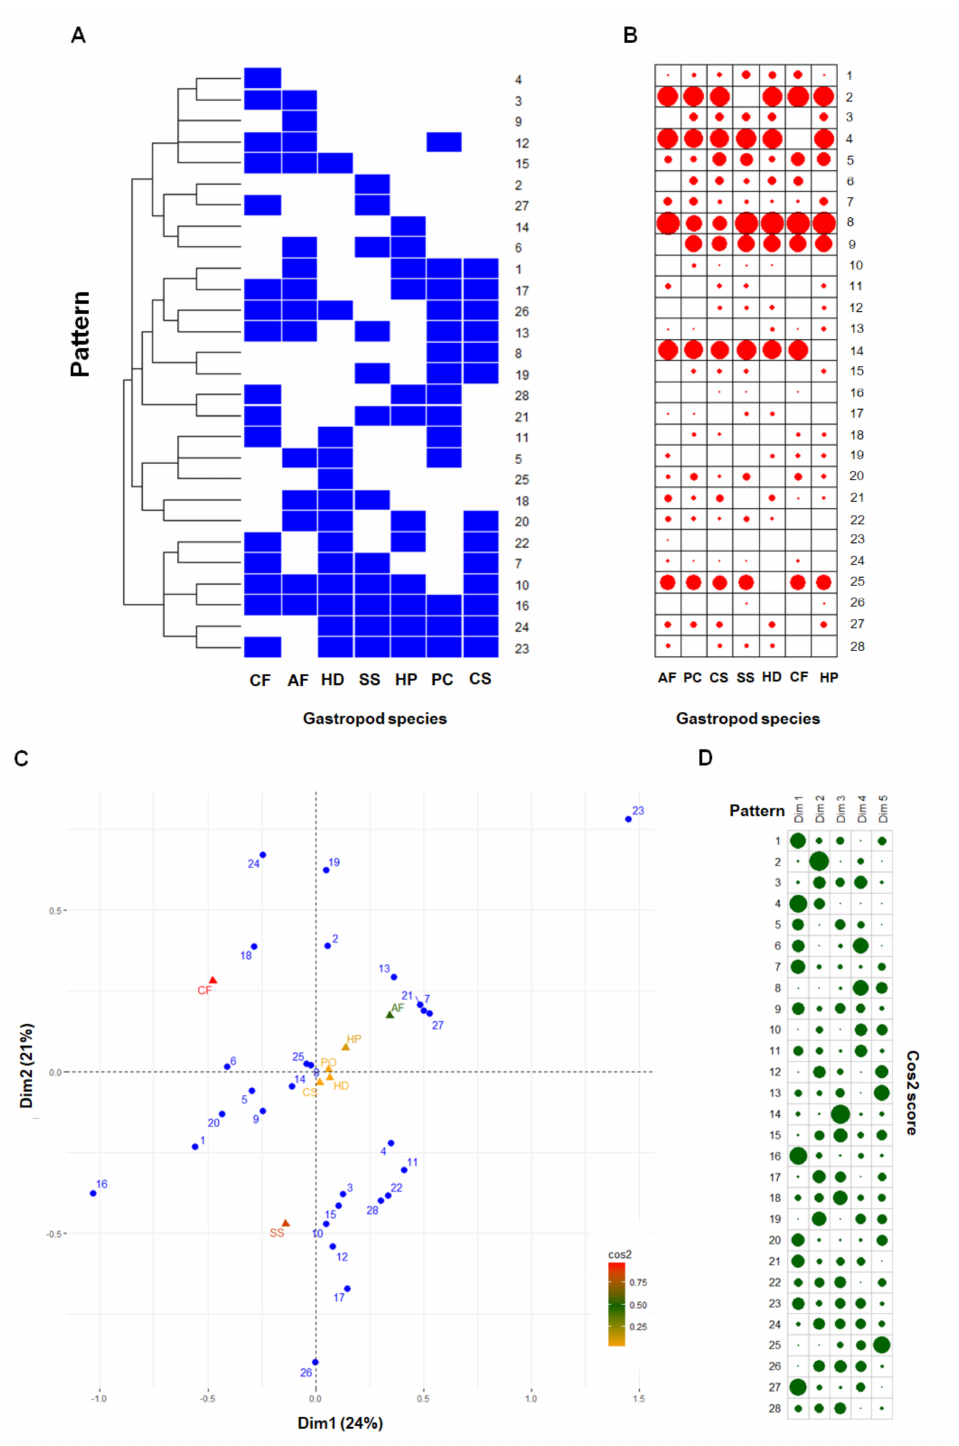
Figure 4. Correspondence analysis of 28 patterns of variable peptides in the mucus of seven gastropod species. Blue squares in the heatmap ( A ) indicate the presence of the peptide, and white squares indicate the absence of a peptide. The sizes of the red circles in the balloon plot ( B ) indicate the number of peptides within each pattern. The biplot ( C ) shows global patterns of the variable peptides (blue circles) and the gastropod species (triangles) according to the first two dimensions (Dim1 and Dim2). Colors of the square cosine scores indicate the gastropod species. The scores for the first five dimensions (Dim1 to Dim5) are shown in ( D ), and the sizes of the green circles represent the score level. AF = Achatina fulica ; PC = Pomacea canaliculata ; CS = Cryptozona siamensis ; SS = Semperula siamensis ; HD = Hemiplecta distincta ; CF = Cyclophorus fulguratus ; and HP = Helix pomatia